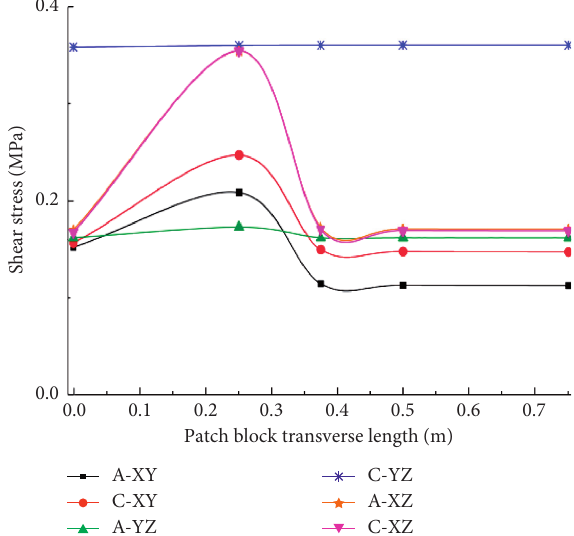
Figure 10: The effect of lateral movement of different loading positions on shear stress of leveling layer.